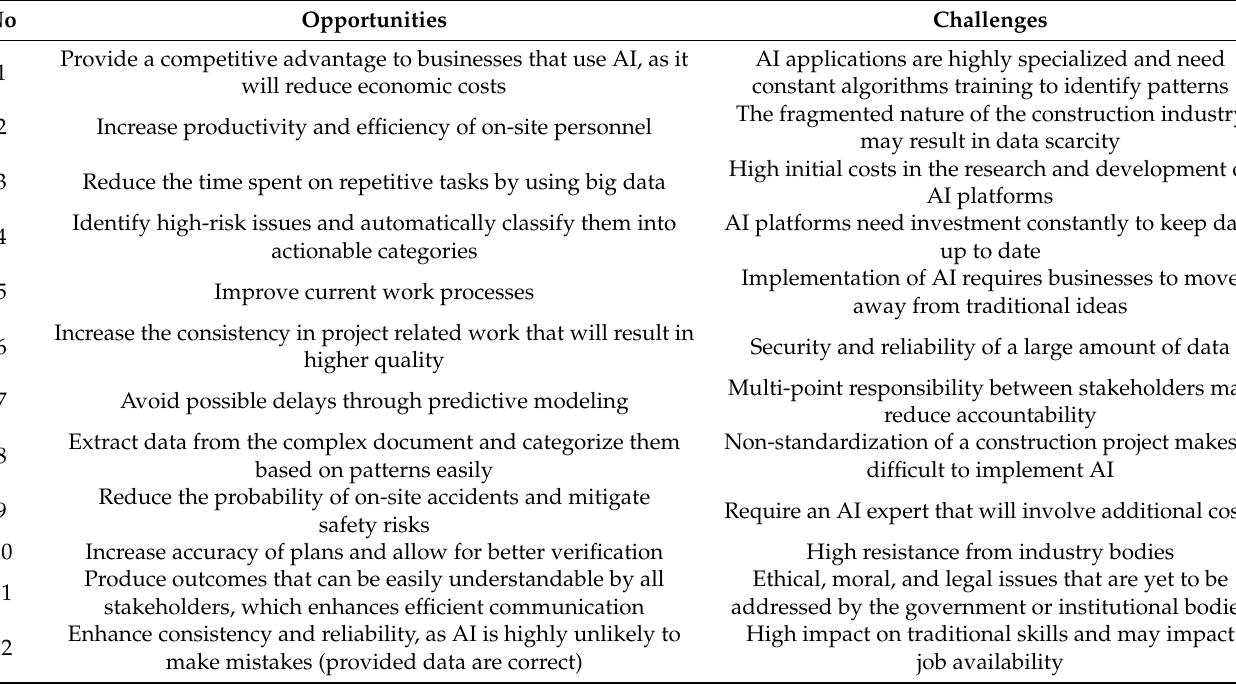
Table 4. AI opportunities and challenges in the construction